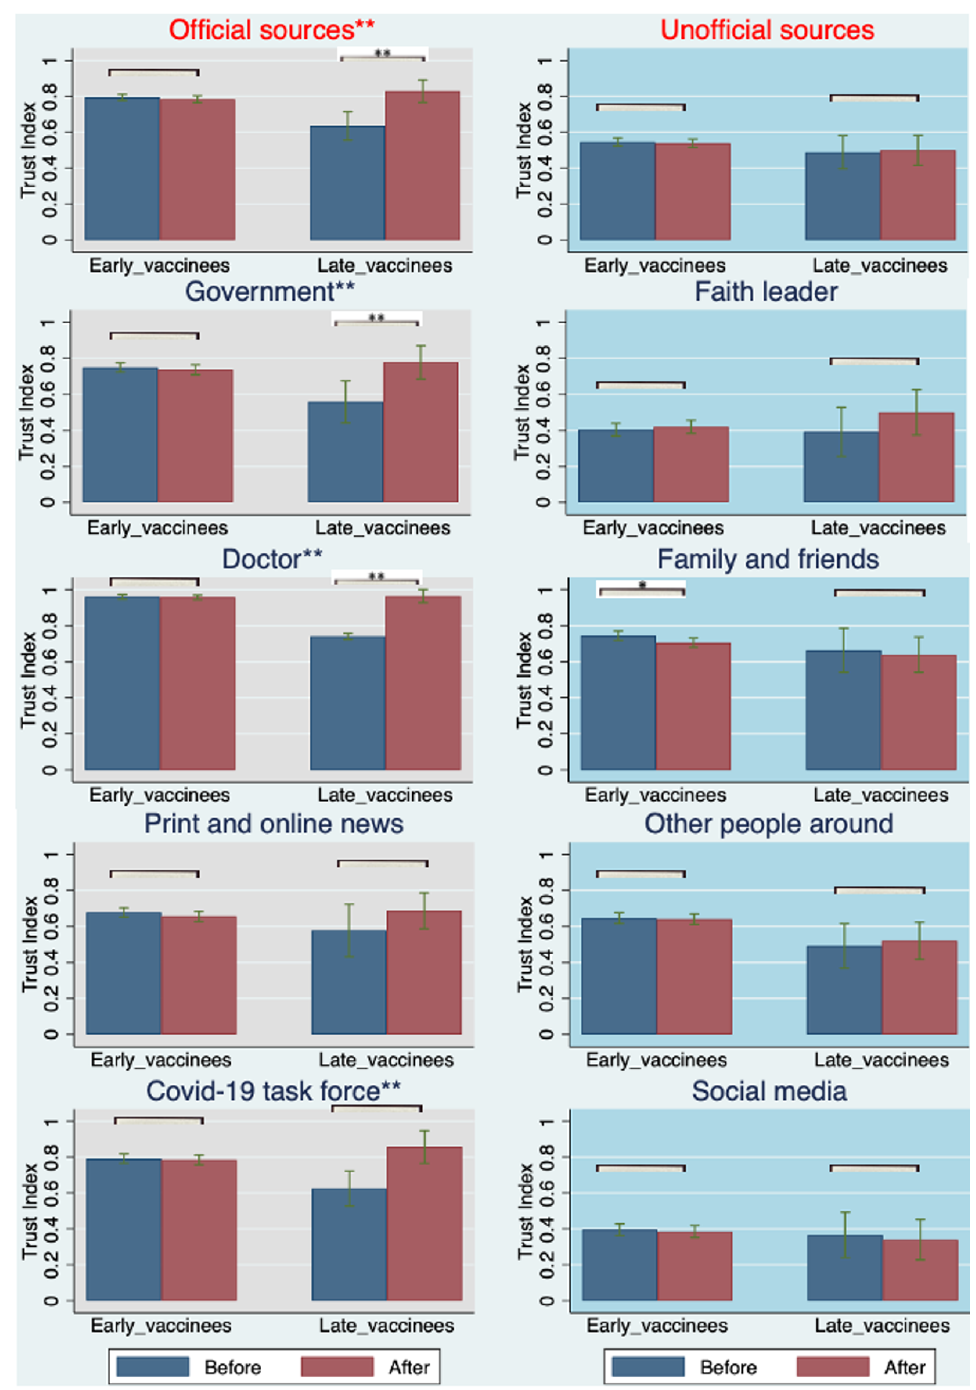
Figure 2. For all early and late vaccinees who received their booster shots, the graphs depict the mean values of trust indexes before and after the booster shots. For each group, separate t -tests were performed, and p -values are reported at the top of each group being compared (gray shadow: official sources; blue shadow: unofficial sources). The star levels on the titles are the comparison between early and late vaccinees on the difference before and after the booster shots. (Statistical significance at * p < 0.05 and ** p < 0.01 are